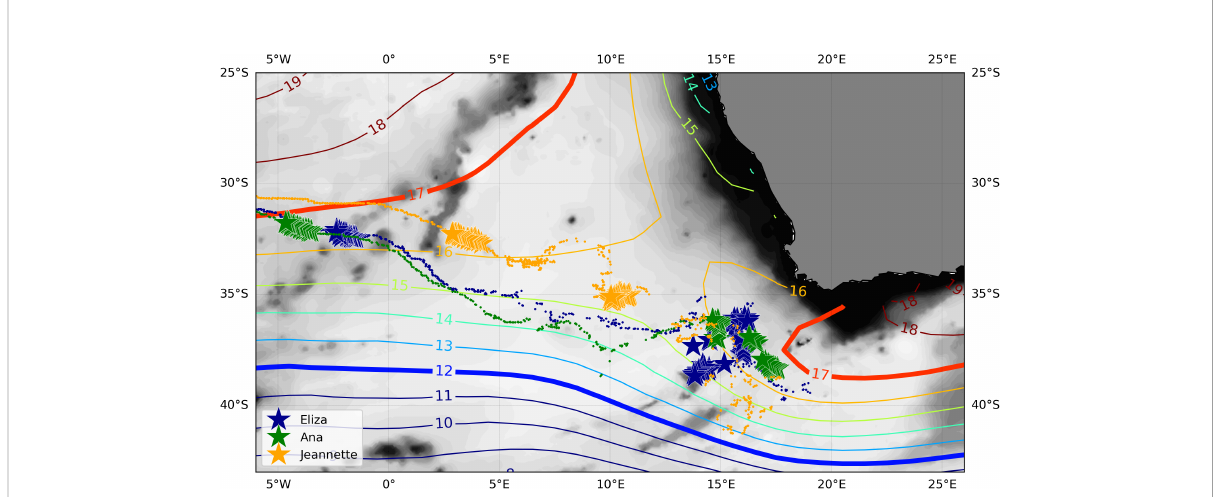
FIGURE 14 Mean sea surface temperature, in degrees Celsius, for the Cape Basin in September (WOA18). The trajectories of the three supersampled rings are plotted over the map. The stars mark the positions of the rings in September, the end of the austral winter. The bottom topography is shown in the background in